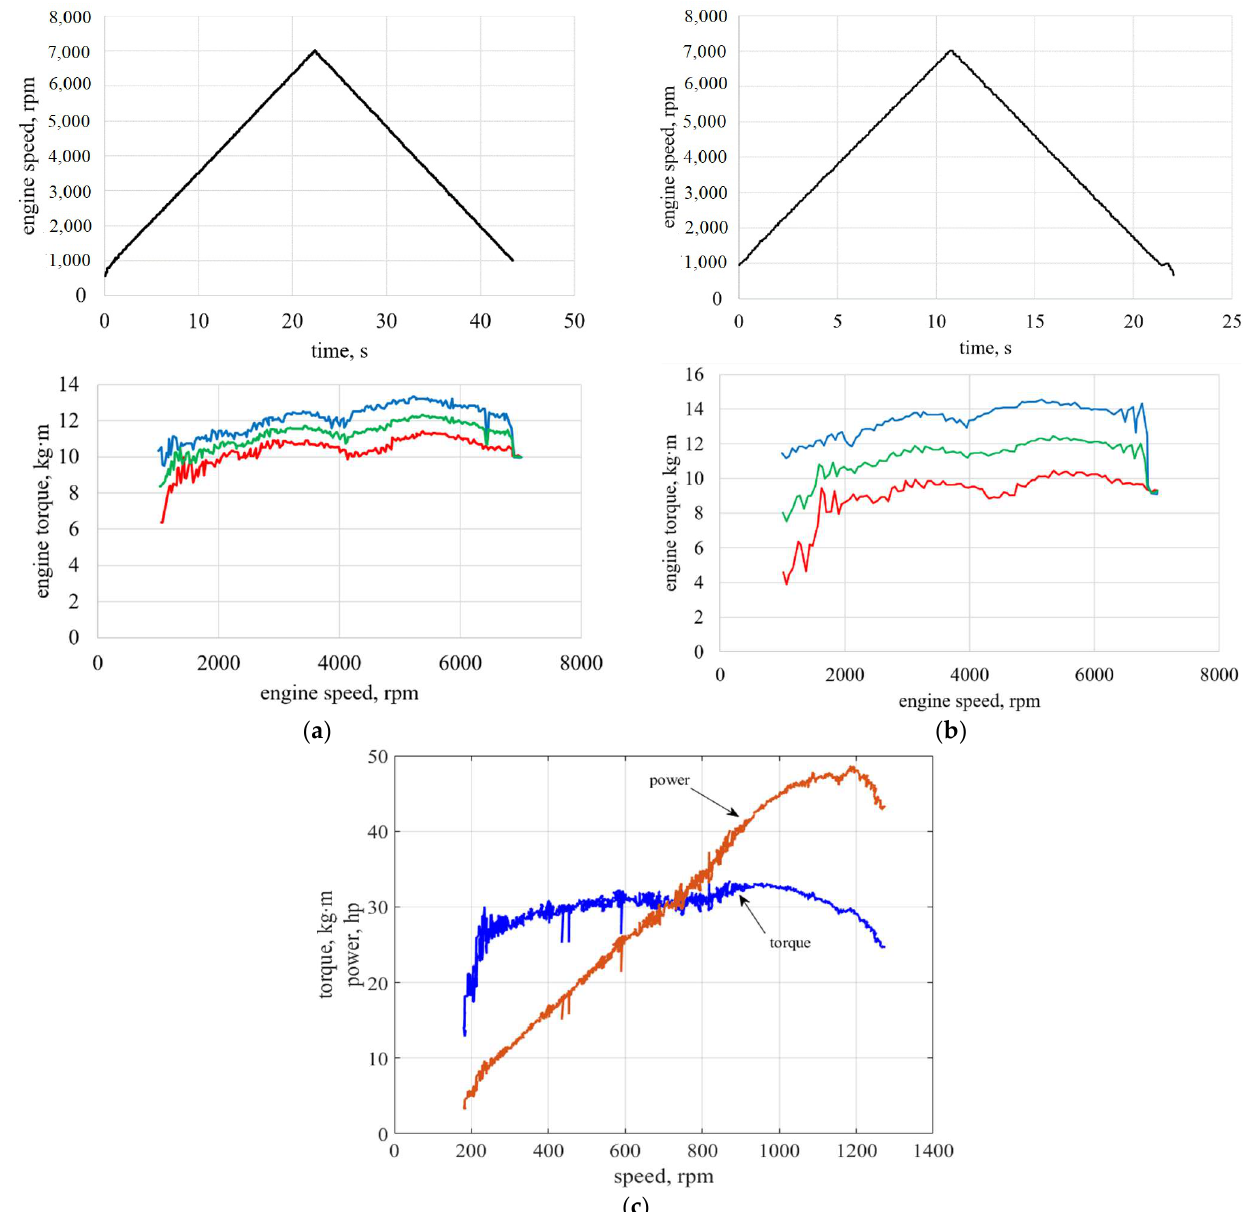
Figure 13. Tachograms and mechanical characteristics of the internal combustion engine during acceleration ±300 rpm/s ( a ), ±600 rpm/s ( b ) (red line—measurements during acceleration, blue—during braking, green—average value); torque and power on the axle shafts ( c ).